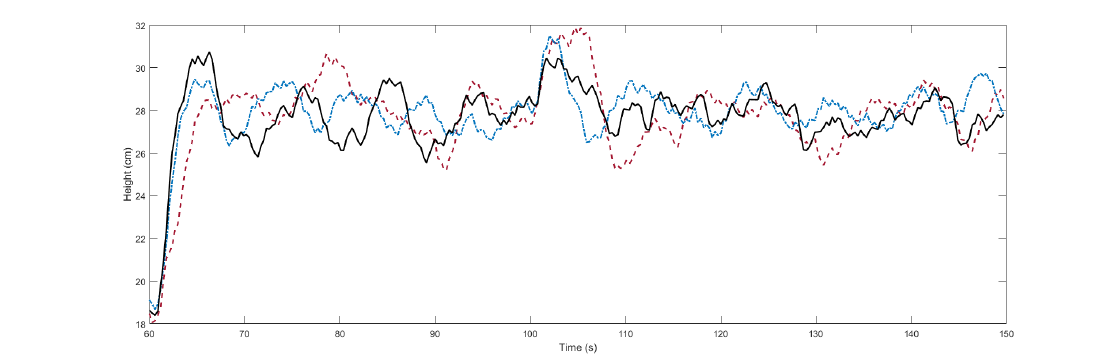
Figure 6. Output response of the air levitation system in the stabilization experiment. Solid black line: proposed algorithm. Dot-dashed blue line: algorithm in [30]. Dashed red line: auxiliary PI